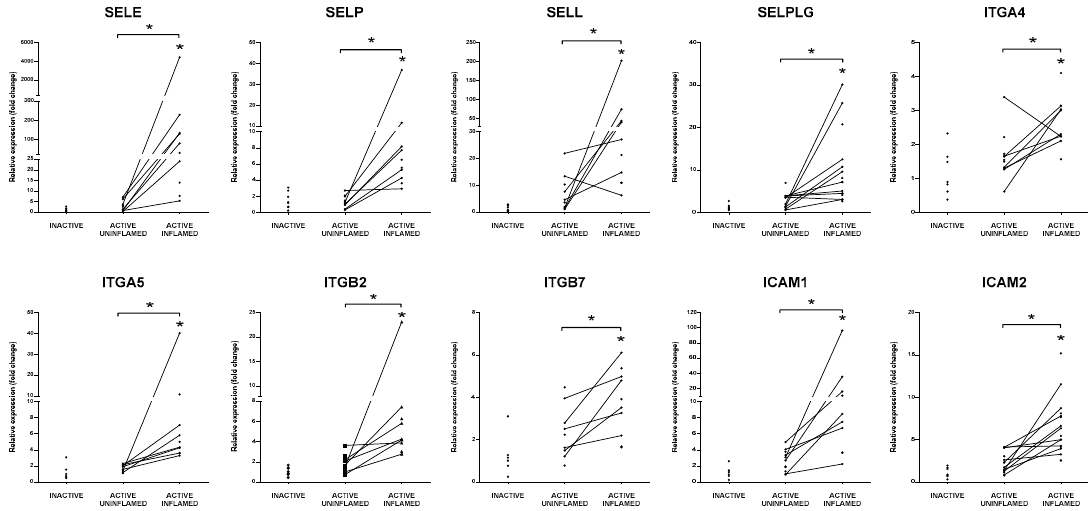
Figure 4. Elevated expression of integrins and selectins indicate increased adhesion of immune cells in the inflamed colon tissue. The relative gene expressions of selectins SELE, SELP, SELL and their ligand SELPLG, integrins ITGA4, ITGA5, ITGB2, ITGB7 and adhesion molecules ICAM1 and ICAM2 are shown from inactive (left), active uninflamed (middle) and active inflamed (right) colon samples of IBD patients. Dots represent individual values, and the lines connect uninflamed and inflamed samples from the same IBD patient; * p < 0.05.